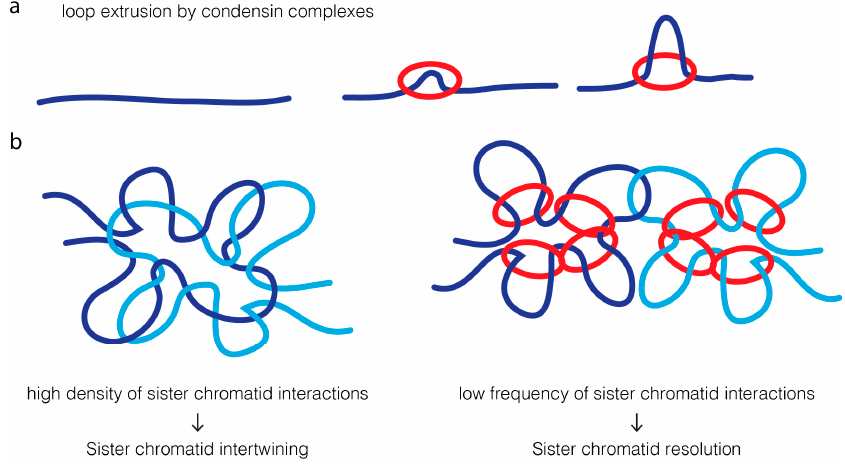
Figure 4. A contact probability model for condensin-directed topoisomerase II reactions. ( a ) Condensin complexes are proposed to create transient loops in the DNA molecule through an extrusion mechanism: binding to a single DNA locus is followed by progressive pulling of DNA strands (dark blue strand) through the condensin ring (red circle), extending the size of the created chromatin loop; ( b ) Proposed model for condensin role in directing the decatenation activity of topoisomerase II. Strands of replicated sister chromatids are initially heavily entangled. In such state, one copy of DNA molecule (light blue strand) has a very high likelihood of its sister DNA (dark blue strand). Topoisomerase II is therefore likely to catalyze re-intertwining intermolecularly, leading to an extensive degree of re-catenation between two sister chromatids. Condensin activity favors the creation of intramolecular chromatin loops, and thereby decreases the contact probability between different DNAs. The physical separation of the two molecules makes them less likely to be re-intertwined together, creating a bias towards intermolecular decatenation.